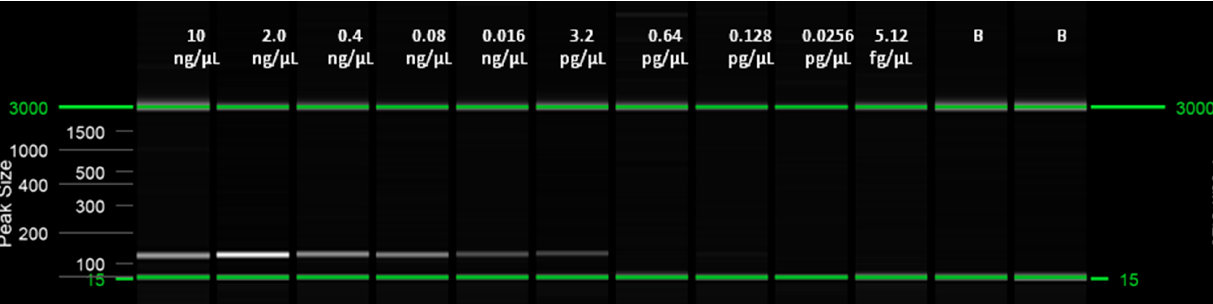
Figure 4. Capillary electrophoresis using the QIAxcel Capillary Electrophoresis System (QIAgen, Valencia, CA, USA) of end point PCR carried out with the primers 14F/125R on serial 1:5 dilutions of artificial DNA from WTB frass.